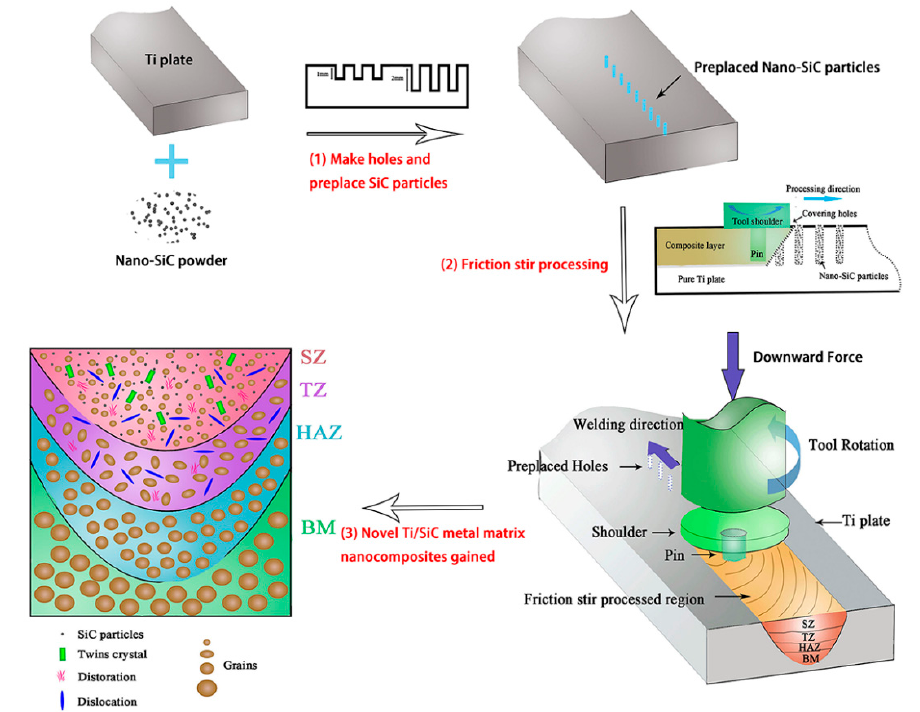
Figure 19. Schematic illustration of the process of producing the FSP-modified Ti / SiC metal matrix nano-composite (MMNC) [117].